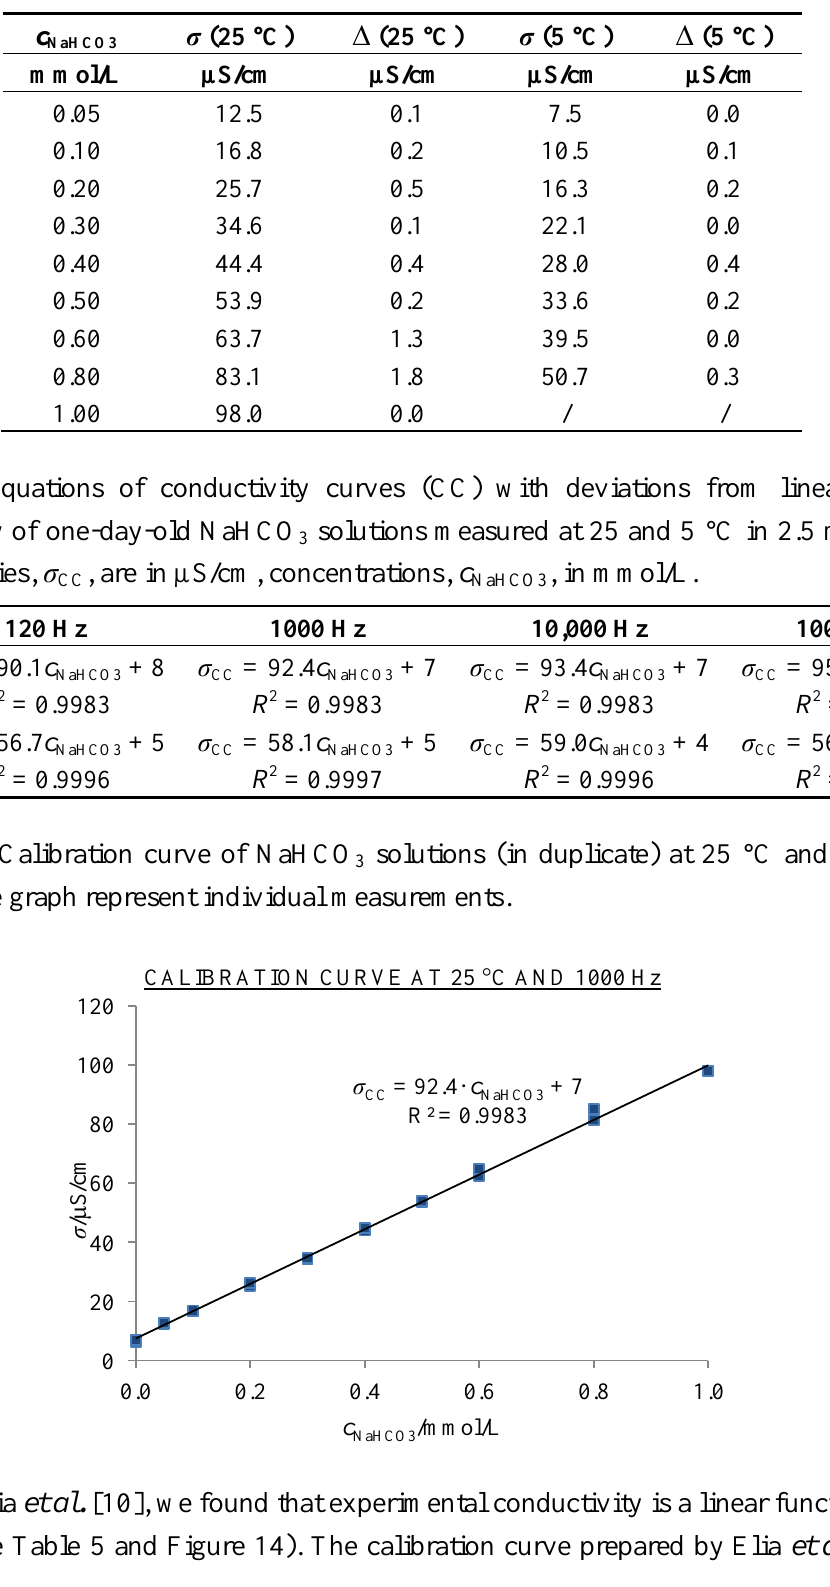
Table 4. Average conductivities of one-day-old NaHCO deviations between the duplicates (∆) measured at 25 and 5 °C and 1000 Hz.